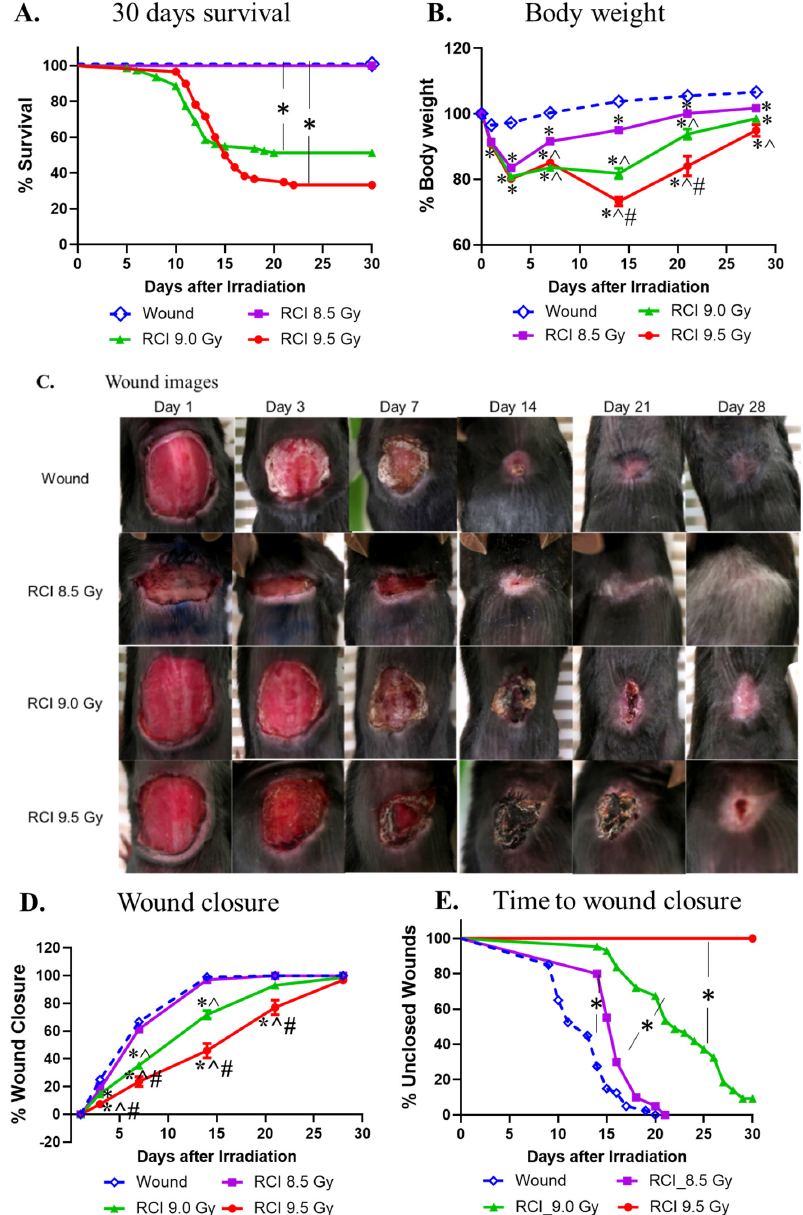
Figure 1. The effects of RCI doses on 30-day lethality, body weight loss, and wound closure delay. ( A ) The 8.5 Gy is a sub-lethal dose, and 9.0 Gy and 9.5 Gy are lethal doses for RCI. * p < 0.05 for Wound/RCI 8.5 Gy vs. 9.0 Gy and Wound/8.5 Gy vs. 9.5 Gy by Log-rank (Mantel-Cox) test; N = 80/20/80/60 for Wound/RCI 8.5/9.0/9.5 Gy. ( B ) RCI resulted in significantly dose-dependent body